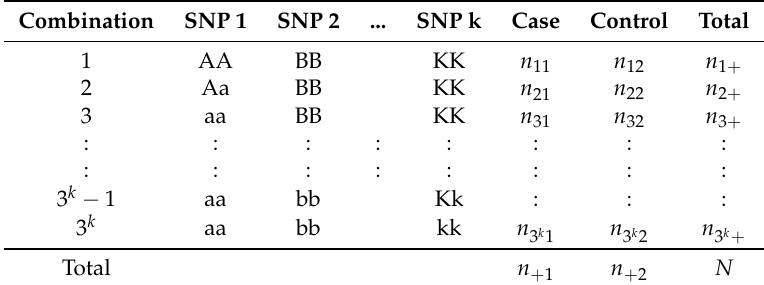
Table 1. A contingency table for the k-order